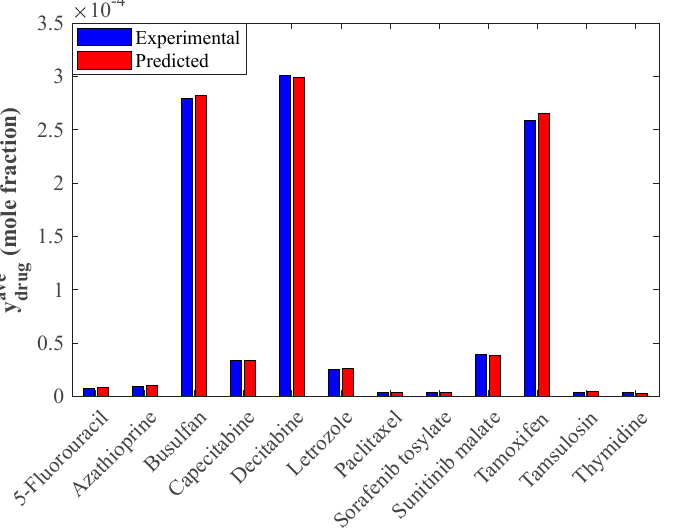
Figure 8. Average values of the solubility in supercritical CO 2 of the studied anticancer drugs achieved from experimental data and modeling results.